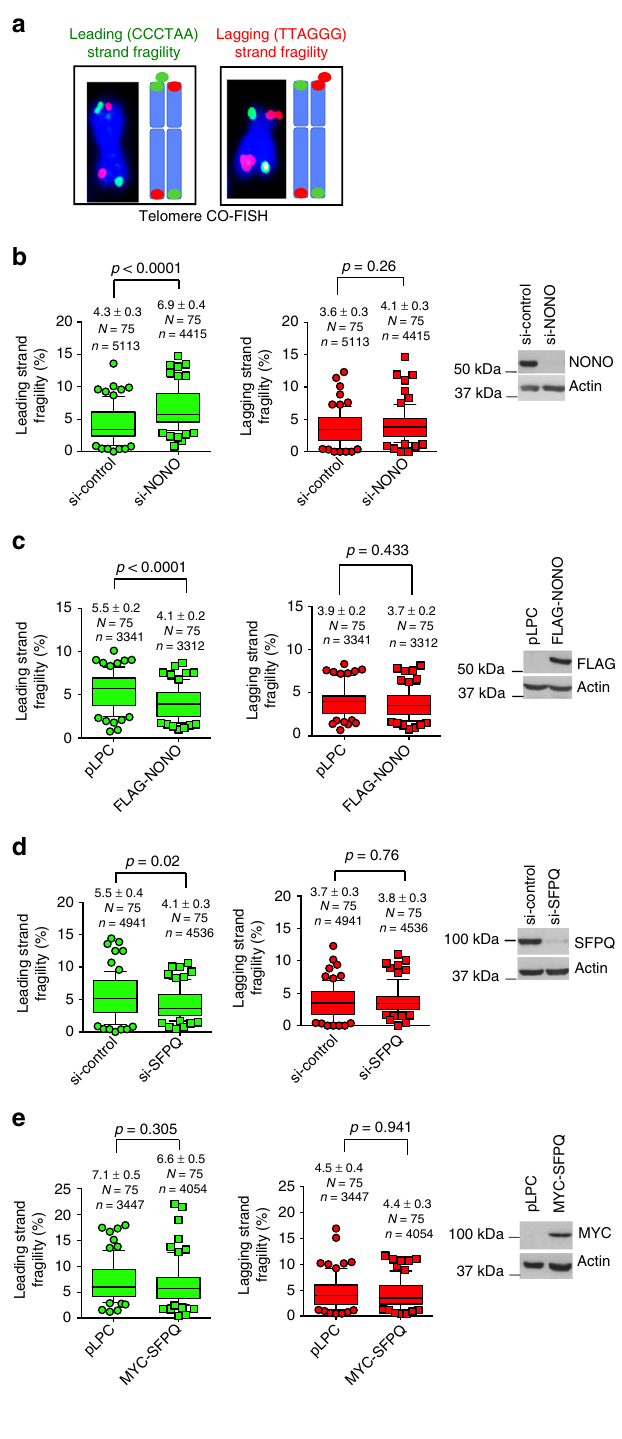
contrast, SFPQ has a critical role in suppressing uncontrolled recombination events triggered by the accumulation of telomere R-loops and replication stress. depleted cells increases the availability of recombinogenic substrates at telomeres that ef fi ciently engage in homologous recombination in the absence of SFPQ. We thus propose that NONO and SFPQ collaborate to suppress RNA:DNA-hybrid triggered telomere recombination in both ALT- and telomerase- positive cancer cells.